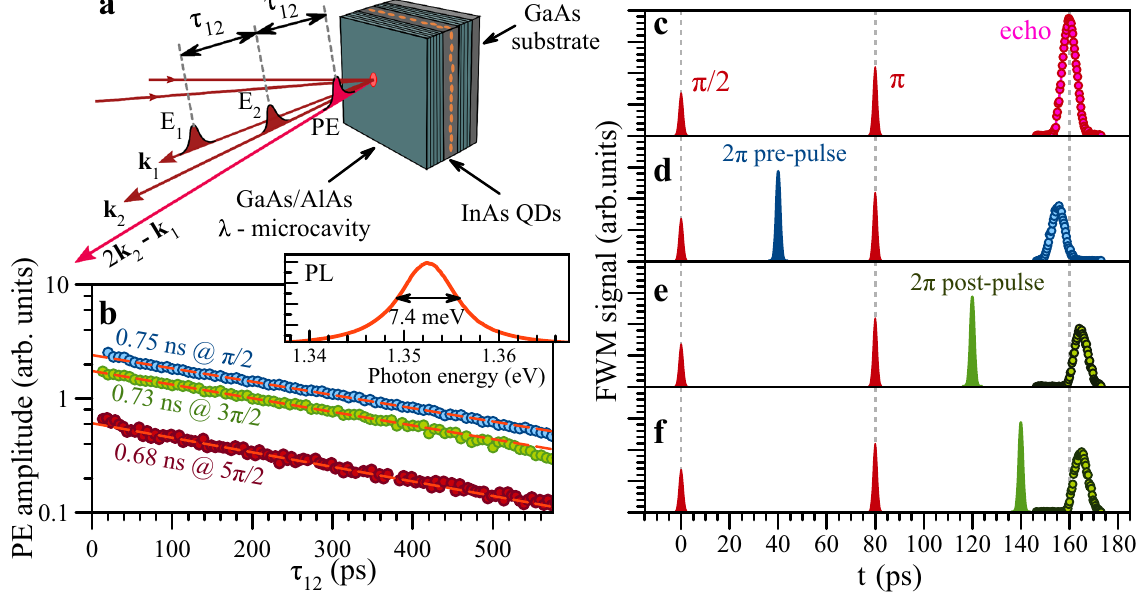
Fig. 2 Photon echo from quantum dots (QDs). a Scheme of photon echo experiment, red arrows indicate the fi rst and second pulses, and magenta arrow indicates direction of the PE emission. b PE decays with increasing delay time τ 12 between pulses fi rst and second for excitation with different fi rst pulse areas Θ 1 . Blue, green, and dark red dots correspond to Θ 1 ≈ π /2, 3 π /2, and 5 π /2, respectively. The second pulse area is Θ 2 ≈ π . The inset shows photoluminescence spectrum for non-resonant cw excitation with photon energy ℏ ω exc = 2.33 eV. c – f Temporal pro fi les of two-pulse PE without control pulse ( c ), in presence of pre- ( d ) and post-control pulse ( e , f ). First and second pulses are schematically depicted in red, pre- and post-control pulses in blue and green. The pulse parameters are Θ 1 ≈ π /2, Θ 2 ≈ π , τ 12 = 80 ps and the control pulse area is Θ C ≈ 2 π